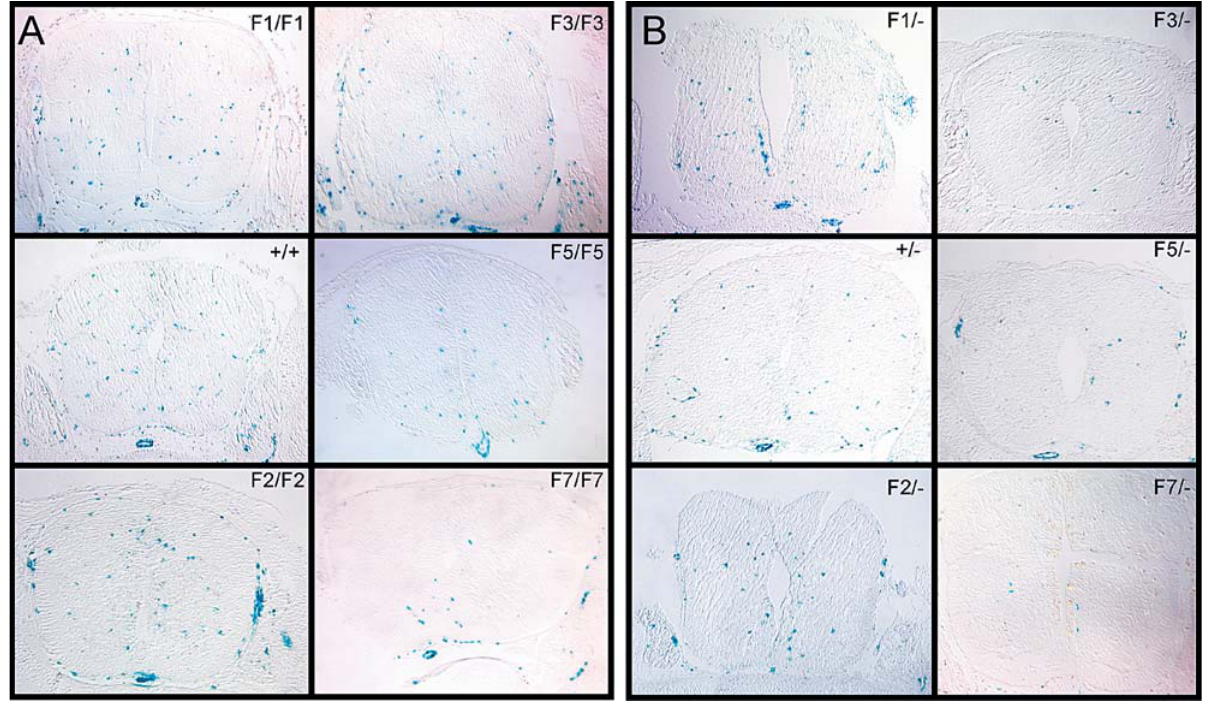
Figure 5. Pericytes within the E14.5 Nervous System of F Series Mutant Embryos (A) Representative sections through neural tubes of embryos from the homozygous F allelic series. (B) Representative sections of embryos from the hemizygous allelic series (F series mutant with one copy of the null allele). Sections are from the rostral level between the heart and kidney. Pericytes are visualized by nuclear-localized b -galactosidase staining in cells committed to the v/p lineage. Sections are 7 l m. DOI: 10.1371/journal.pbio.0000052.g005